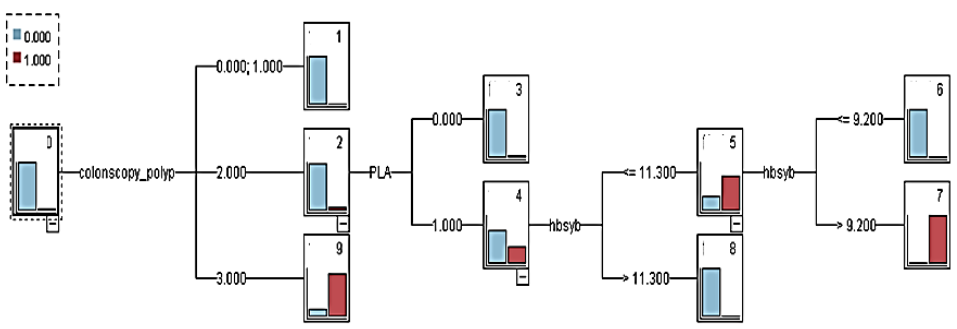
Figure 3. Decision tree model 1 (no pyogenic liver abscess variable).